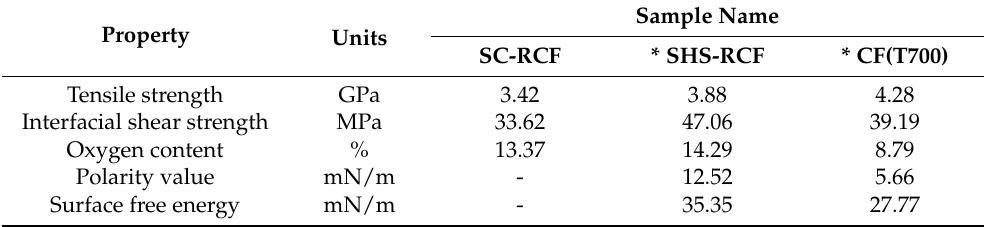
Table 1. Summary of the results of previous studies according to carbon fiber type (B. J. Kim et al.) [23].